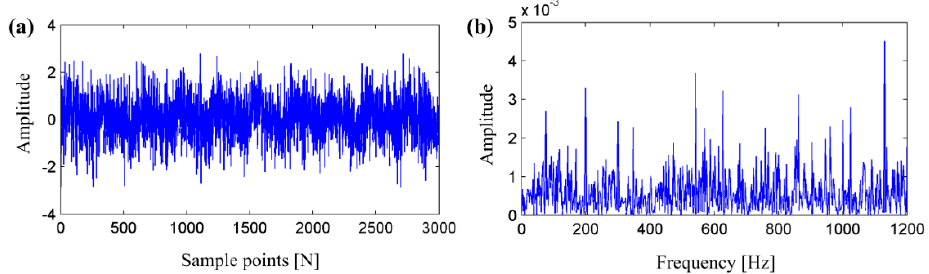
Figure 5. ( a ) The stimulated fault vibration signal; ( b ) The envelope spectrum of ( a ).